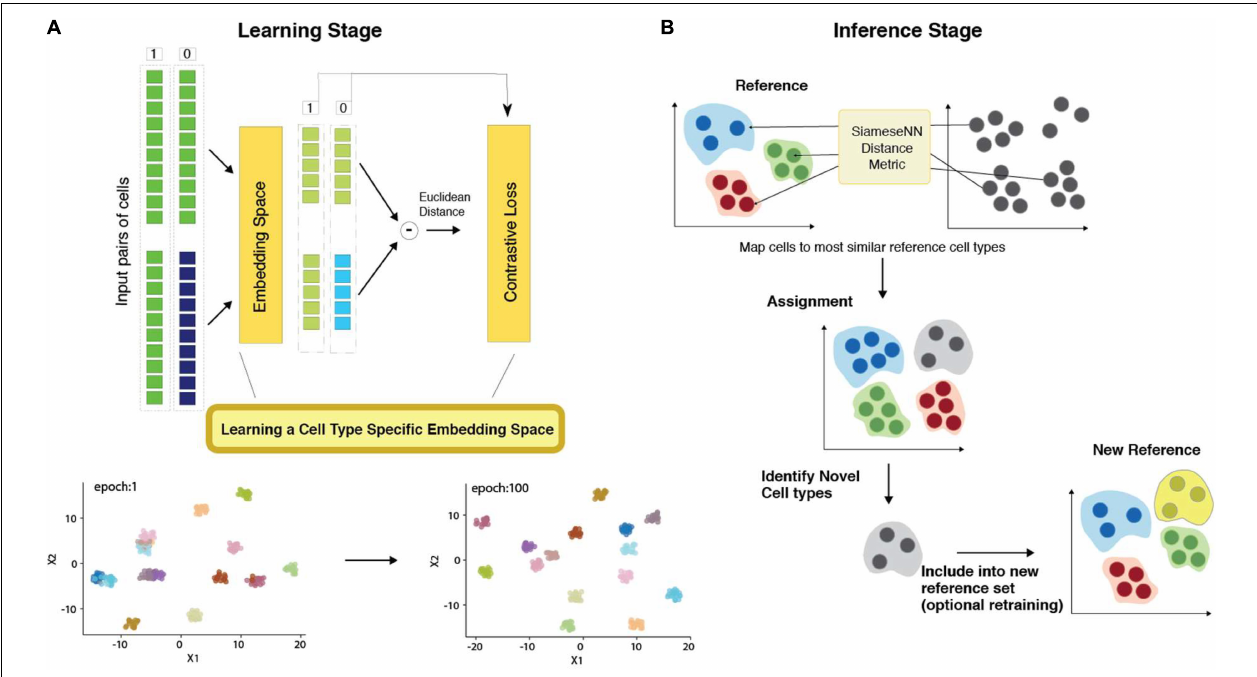
FIGURE 1 | Architecture of MapCell Siamese Neural Network (SNN). (A) (Top) SNN architecture (Bottom) Low-dimensional representation of embedding space. (B) SNN inference: Each cell in the sample set is compared using the SNN metric to a set of reference cells used in the learning stage. The assignment is made to the closest reference type. Cells that do not meet the threshold are flagged as novel cell types. These novel types can be reincorporated into the training set to generate a new SNN or included in the reference set without